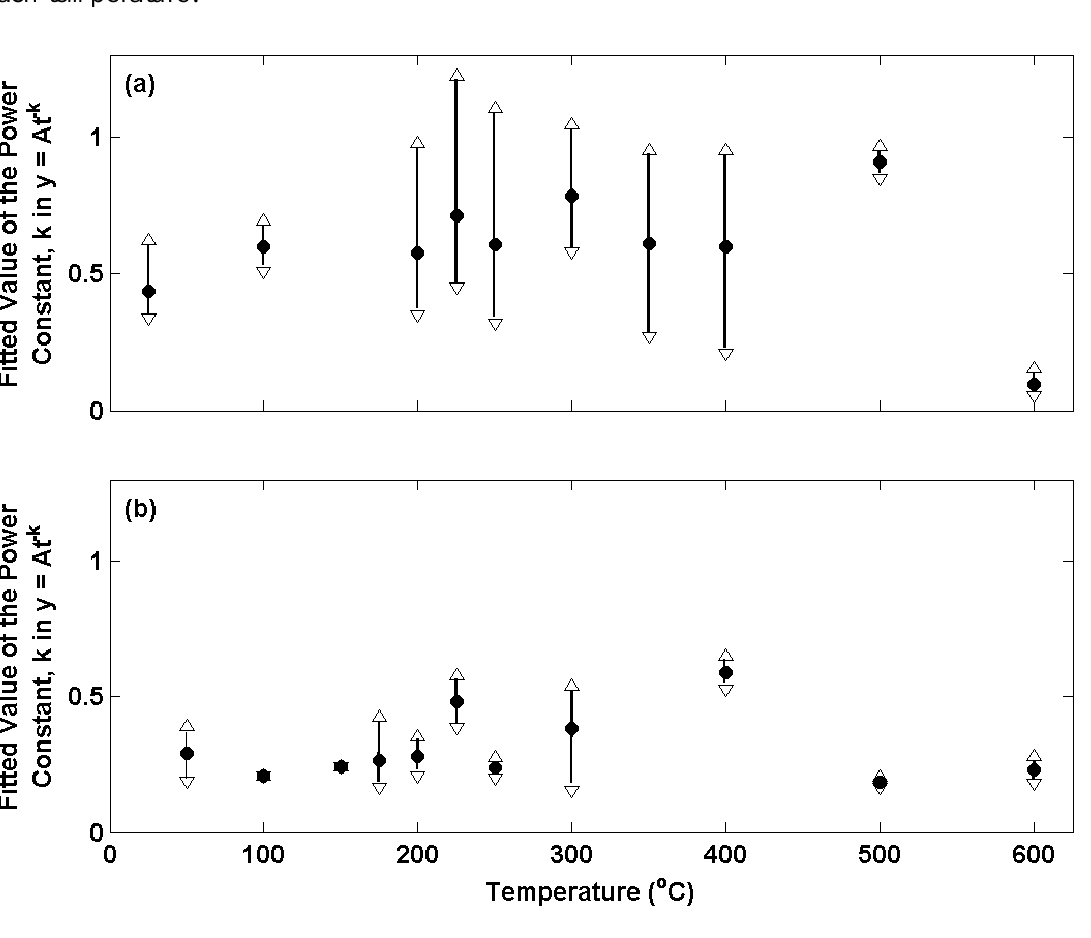
Figure 7. Transient potential difference measurements for electrolytic Ag/AgCl electrodes vs. a thermal electrolytic defacto reference electrode after transfer from a 0.01 M HCl solution to a 0.025 M Na HPO / 0.025 M KH PO buffer solution. The electrodes were 2 4 2 4 equilibrated in a 0.01 M HCl solution prior to transference. The value of the exponent, k, in the power function of type y = A t -k was fitted to the first 60 s of the transient potential difference measurements and is plotted as a function of annealing temperature for Ag wire annealed in (a) air and (b) nitrogen. The black circles represent the mean power constant determined for the ensemble of electrodes at each annealing temperature. The triangles indicate the upper and lower power constants determined for the electrode ensemble at each